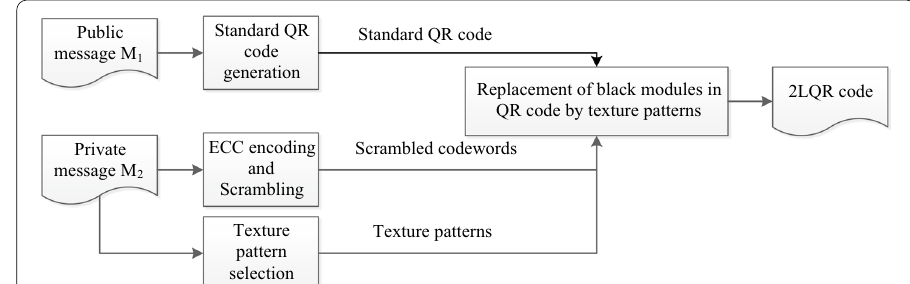
Fig. 5 The generation process of 2LQR code